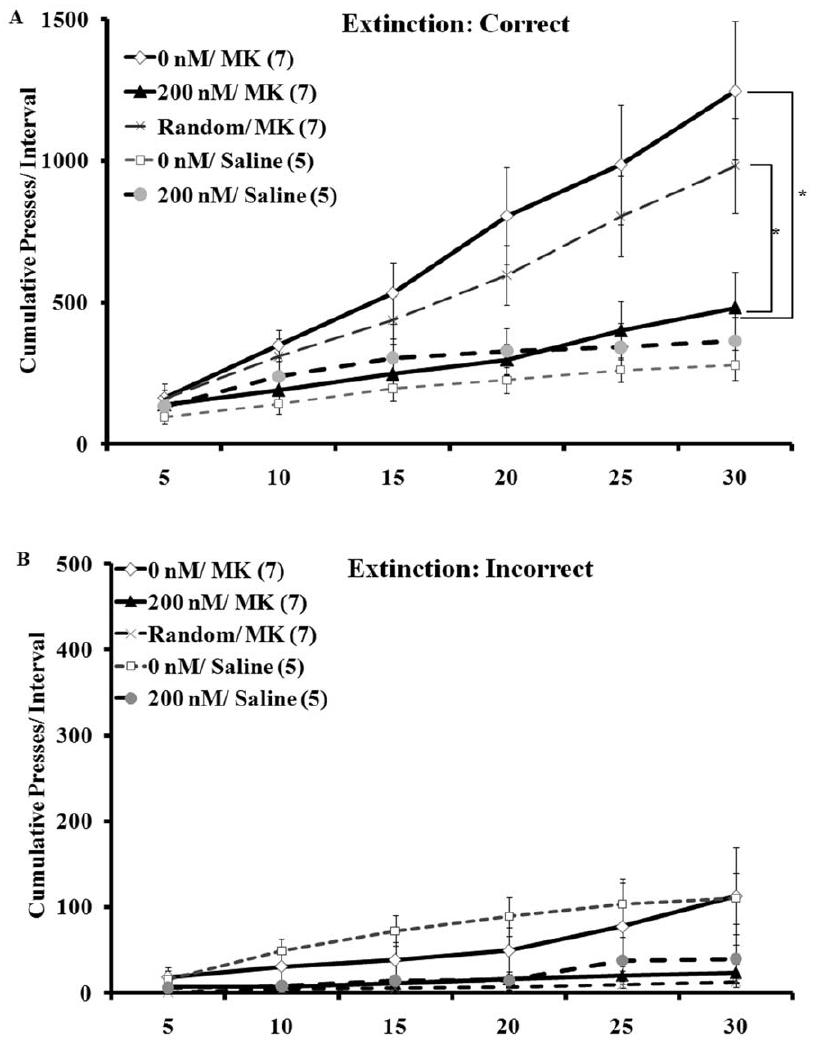
Figure 2. Intra-accumbens aptamer injection reverses the MK-801-induced elevation in extinction pressing. A) Cumulative correct lever responses per 5-min interval over the 30-min extinction session. B) Cumulative number of incorrect lever presses per 5-min interval over the 30- min extinction session. Groups pretreated with intra-accumbens vehicle (0 nM/ MK; n=7) or the random oligonucleotide sequence (Random/ MK; n=7) and systemically with 0.1 mg/ kg MK-801 showed elevated correct lever pressing throughout the entire 30-min extinction session compared to animals pretreated with 200 nM dose of the aptamer (200 nM/ MK; n=7) and both groups treated systemically with saline (0 nM/ saline; n=5 and 200 nM/ saline; n=5). Correct extinction pressing was not significantly different between the 200 nM/ MK group and the 0 nM/ saline or the 200 nM/ saline groups. *, p , 0.05; numbers in parentheses=animals per group. No significant differences were detected when measuring incorrect lever presses during the extinction session. Data expressed as mean 6